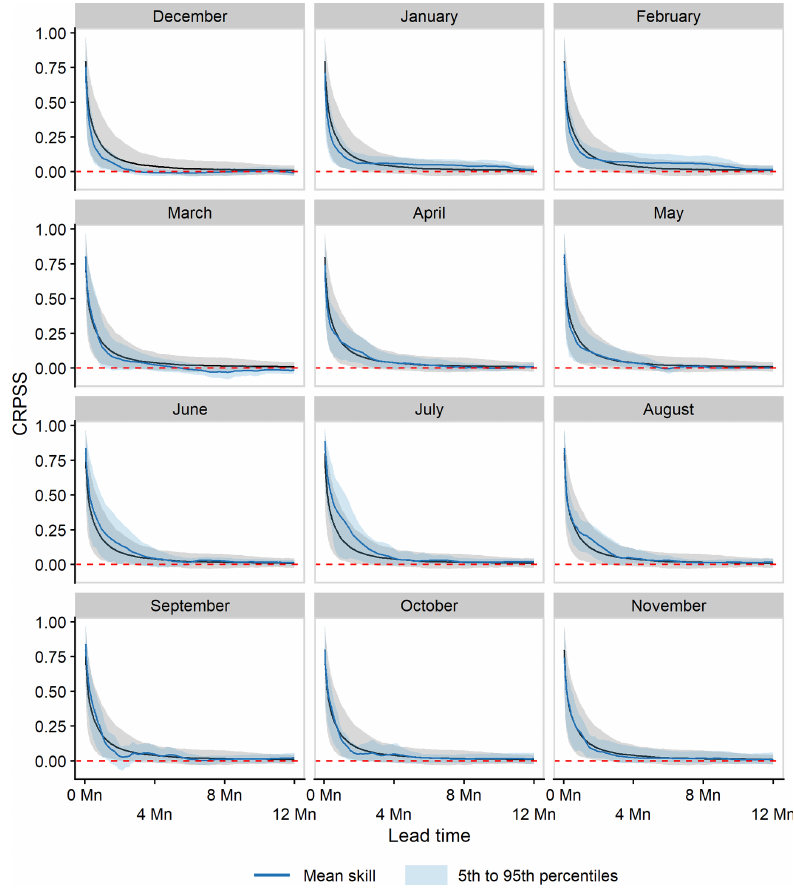
Figure 4. As in Fig. 3 but for each forecast initialisation month. Data from Fig. 3 are included in the background of each panel for reference.